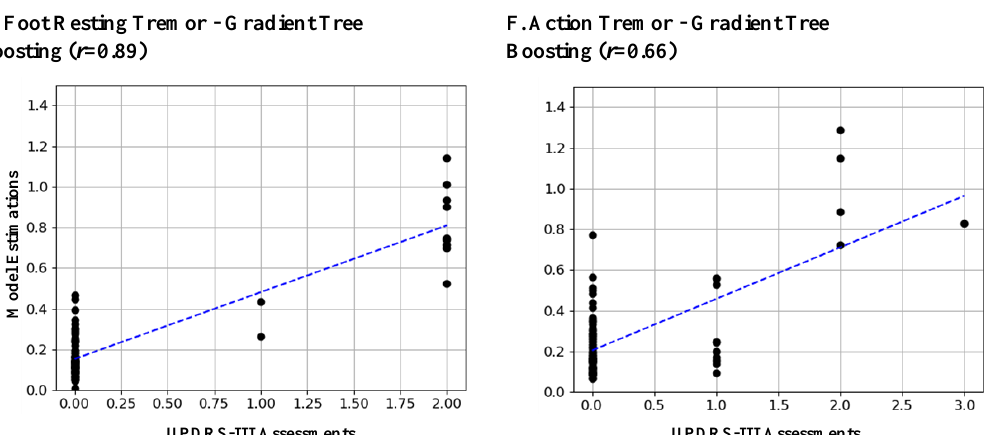
Figure 2. The estimated tremor subscores versus the values estimated from the UPDRS-III assessment. ( A ) The total tremor subscores using the LSTM method; ( B ) The total tremor subscores using the gradient tree boosting method; The estimations using the gradient tree boosting for ( C ) total resting tremor; ( D ) hand resting tremor; ( E ) foot resting tremor; and ( F ) action tremor. The blue dashed line indicates the fitted line to the